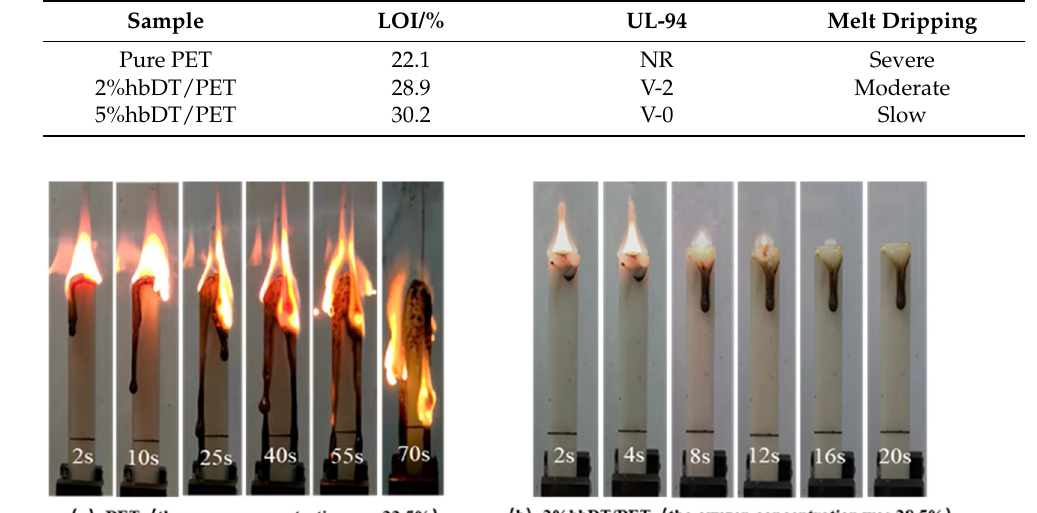
Table 2. LOI values and UL-94 test data of different hbDT/PET composites.